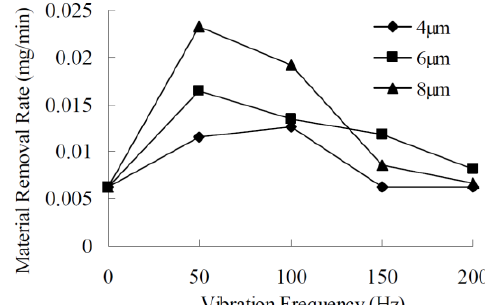
Figure 10 Effect of vibration frequency on the MRR, reprinted from